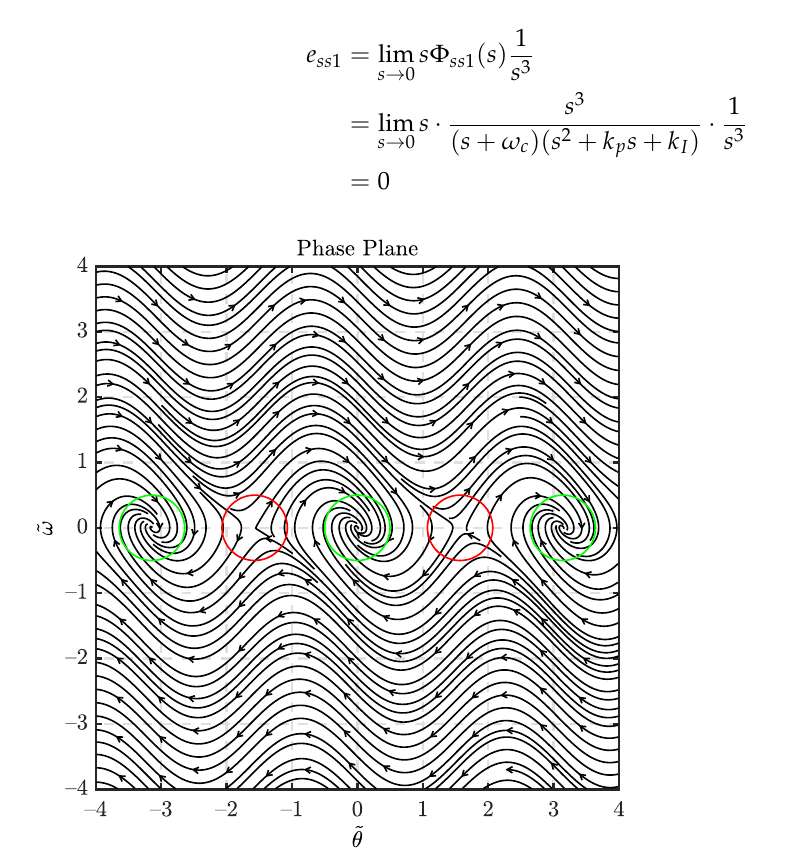
Figure 8. Improved PLL phase